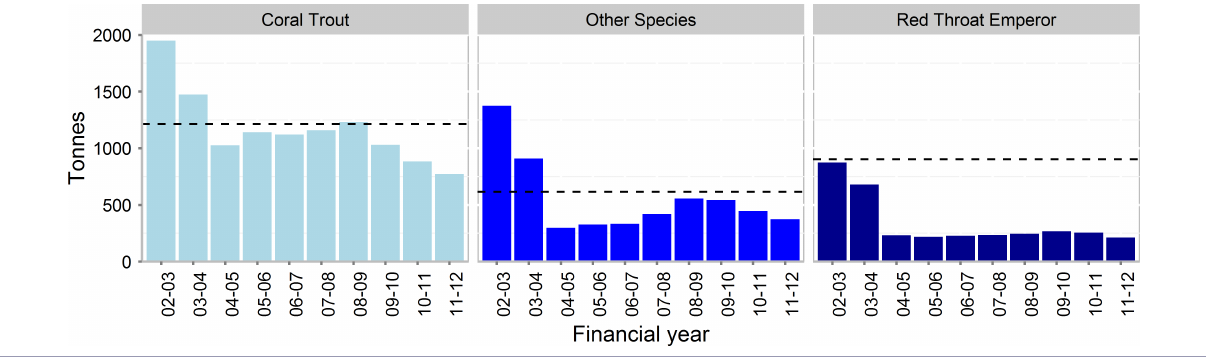
Fig. 2 . Landings over time for coral trout, other species, and red throat emperor quota groups. Total allowable catches (beginning 2004-2005) are denoted by the dashed horizontal